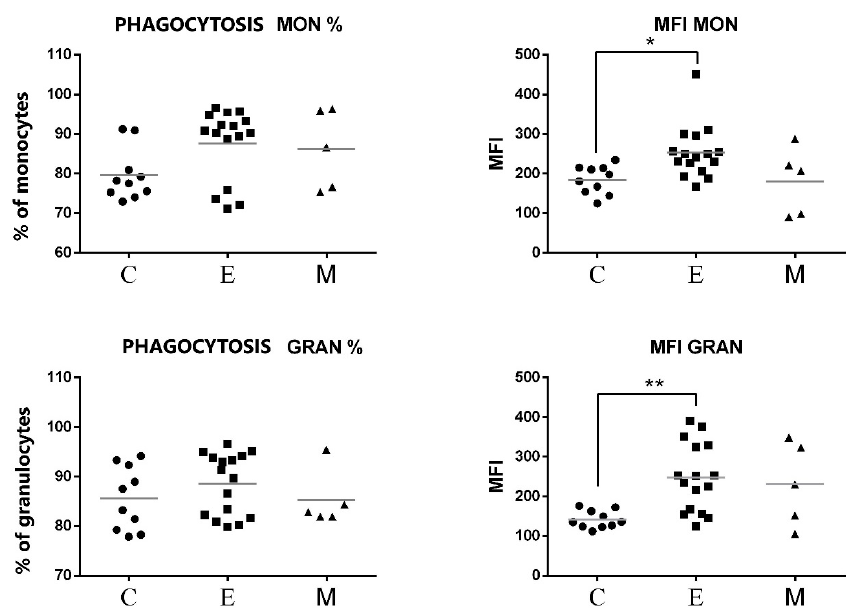
Figure 7. Flow cytometric results showing the mean values of the percentages and MFI of phagocytic cells (monocytes and granulocytes) after exposure to fluorescent labeled E. coli in the peripheral blood of female dogs with malignant tumors of diverse origin and the control group. Mean values of phagocyte percentages ( ± SD) in female dogs with tumors of epithelial origin (E); female dogs with tumors of mesenchymal origin (M); and the control group (C). Statistically significant differences at p < 0.05 (*); at p < 0.01 (**).